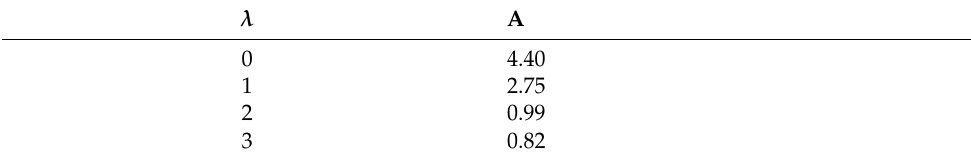
Table 1. Fitted values of the amplitudes A for different values of the activity λ in the weak shear